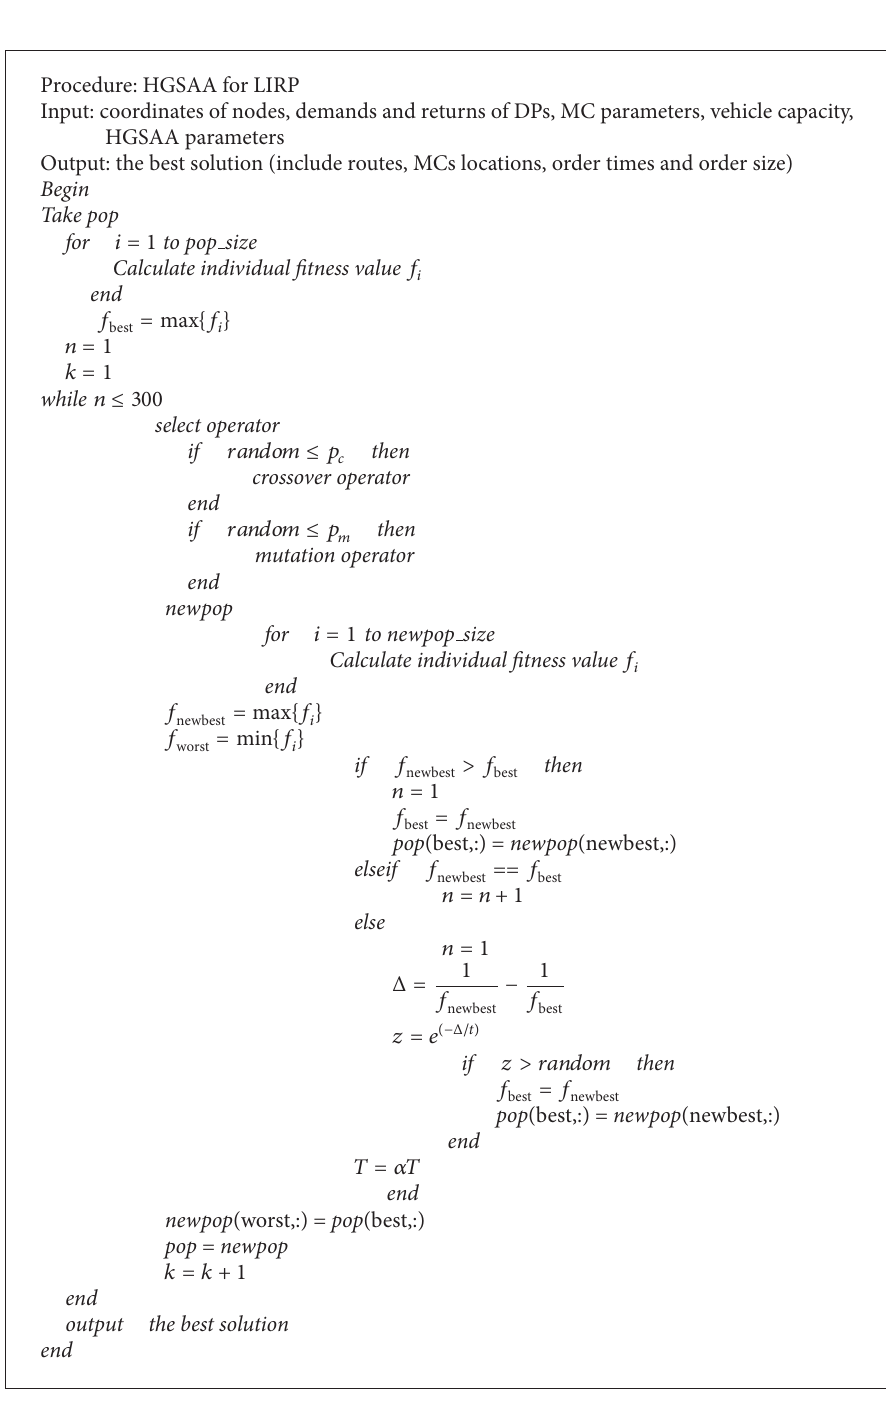
Pseudocode 1: Pseudocode of the proposed HGSAA. Table 1: Solution of Gaskell 67-29 ×